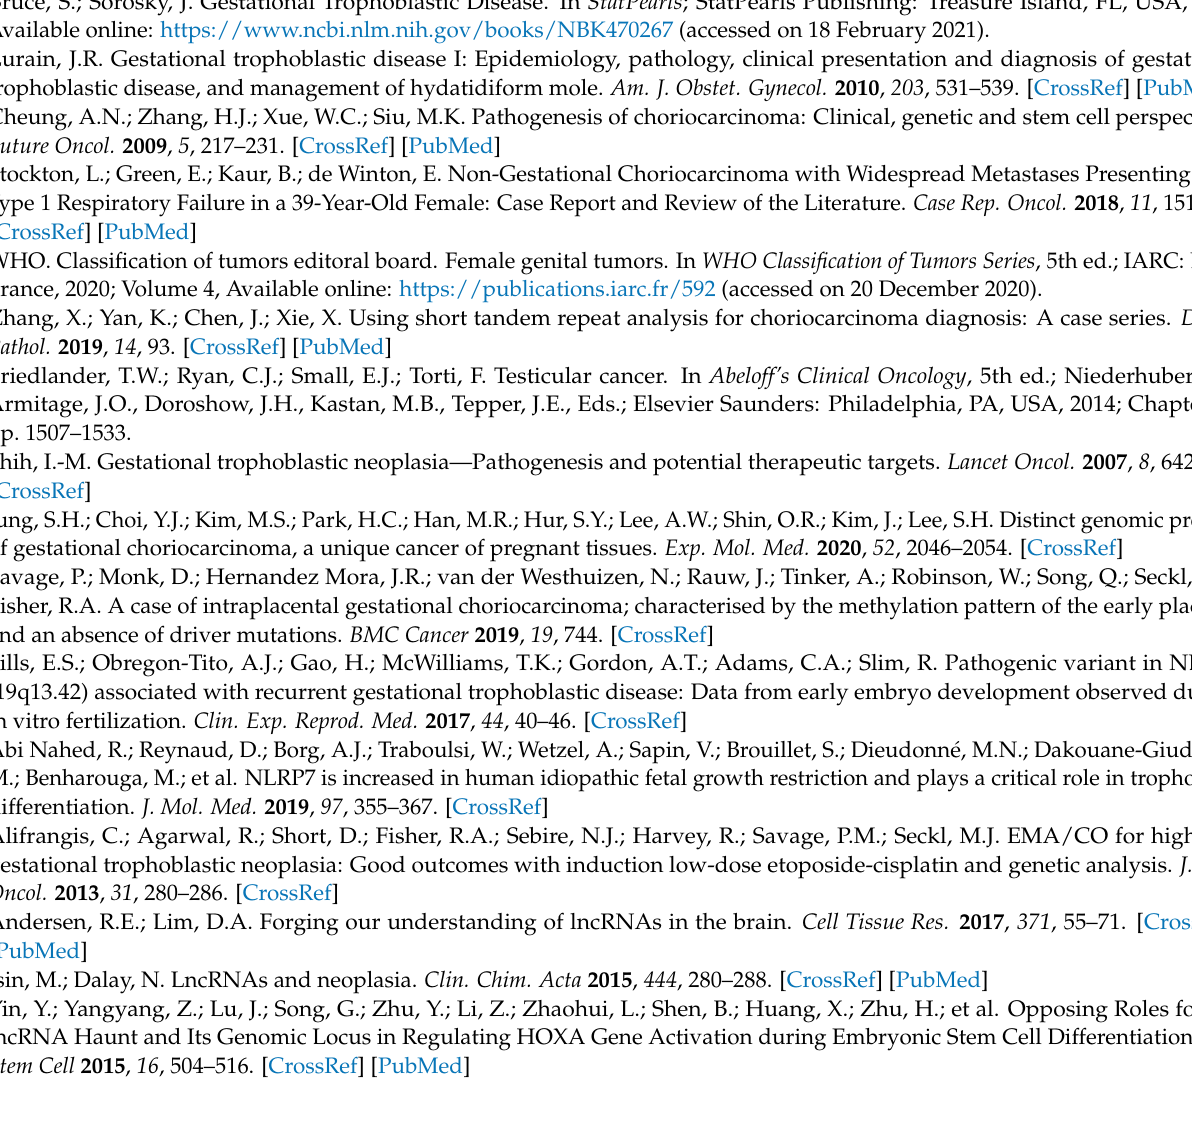
FIGO F é d é ration Internationale de Gyn é cologie et d’Obst é trique GBM glioblastoma multiforme HPV human papillomavirus LINC00261 long intergenic non-coding RNA 00261 LncRNA long non-coding RNA LNAGapmeRs locked nucleic acid GapmeRs MEG3 maternally expressed gene NATs natural antisense transcripts ncRNA non-coding